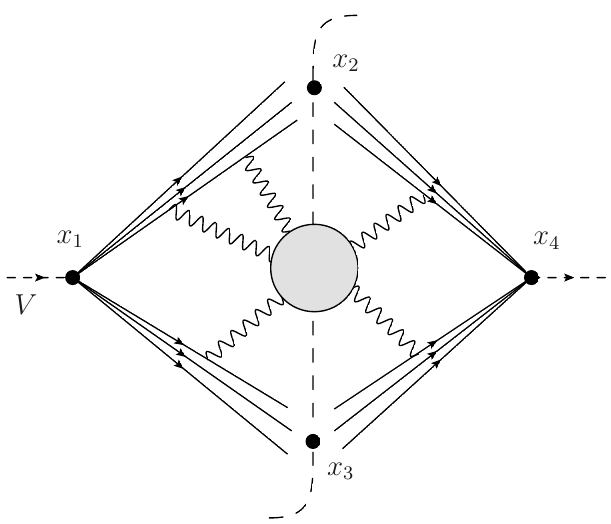
Figure 1 . Unitary diagram describing a two-jet cross-section. The graphs to the left and to the right of the unitary cut (dashed line) describe the scattering amplitude V ! everything and its complex conjugate counter-part. Solid and wavy lines denote collinear and soft particles, respectively. The grey blog describes the interaction between soft particles. In the dual description, the ‘source operators’ are located at the points x 1 and x 4 and the ‘calorimeter operators’ are at the points x 2 and x 3